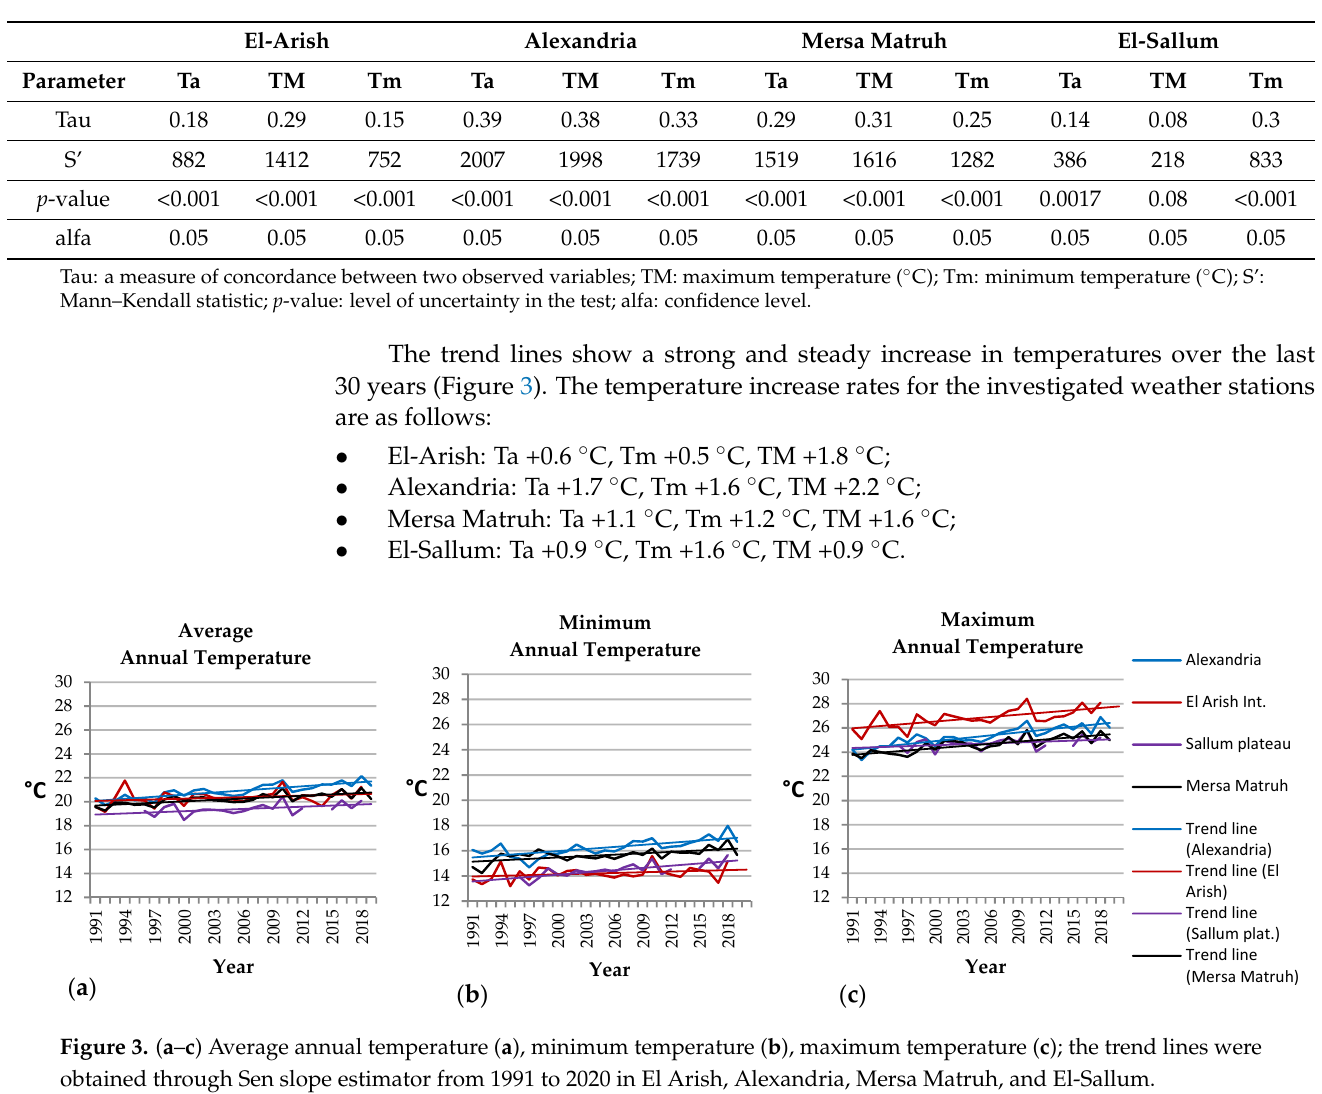
Table 5. Results of Mann–Kendall test seasonally adjusted for all weather stations at monthly scale from 1991 to 2020 in El Arish, Alexandria, Mersa Matruh, and El-Sallum.